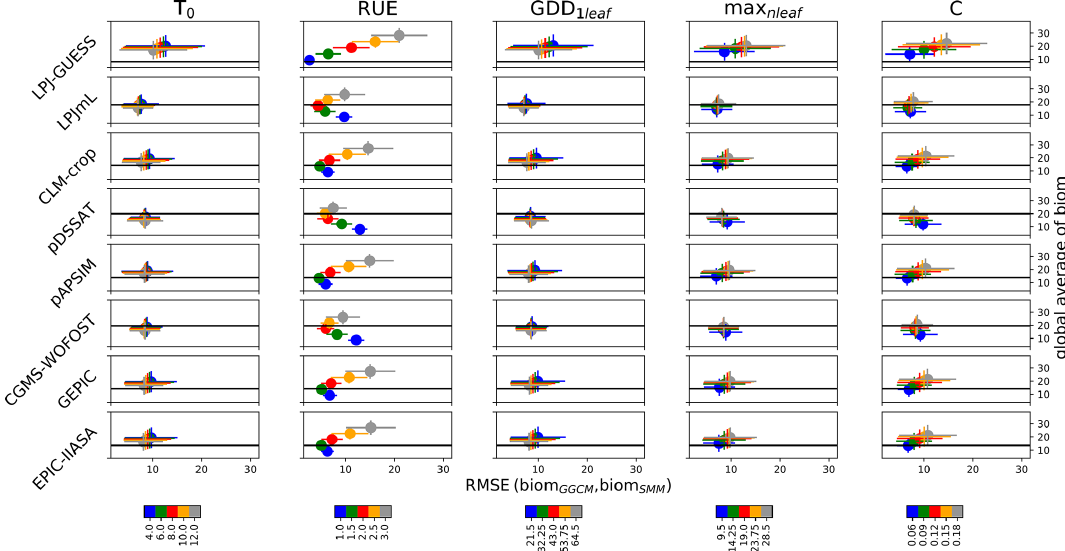
Figure 2. Global RMSE (biom SMM , biom GGCM ) and global averaged biom SMM sensitivity to SMM parameters. Five different values are used for each SMM parameter, and thus 5 5 SMM simulations have been performed. The different lines correspond to the different GGCMs. For a given line and for a given column (i.e., for a given SMM parameter), each dot represents all SMM simulations sharing the same value for this parameter, which defines its color. Error bars correspond to the standard deviation among these SMM simulations. Each dot is defined through the RMSE(biom GGCM ,biom SMM ) ( x axis, in tha − 1 ) and the global averaged biom SMM ( y axis, in tha − 1 ). The black horizontal line reports the global averaged biom GGCM on the y axis. The difference of biom SMM between rows for a given column results from differences in growth periods between GGCMs (and to a lesser extent from the difference in the spatial coverage of maize between GGCMs). Global values (average, RMSE) are computed by giving the same weight to each grid